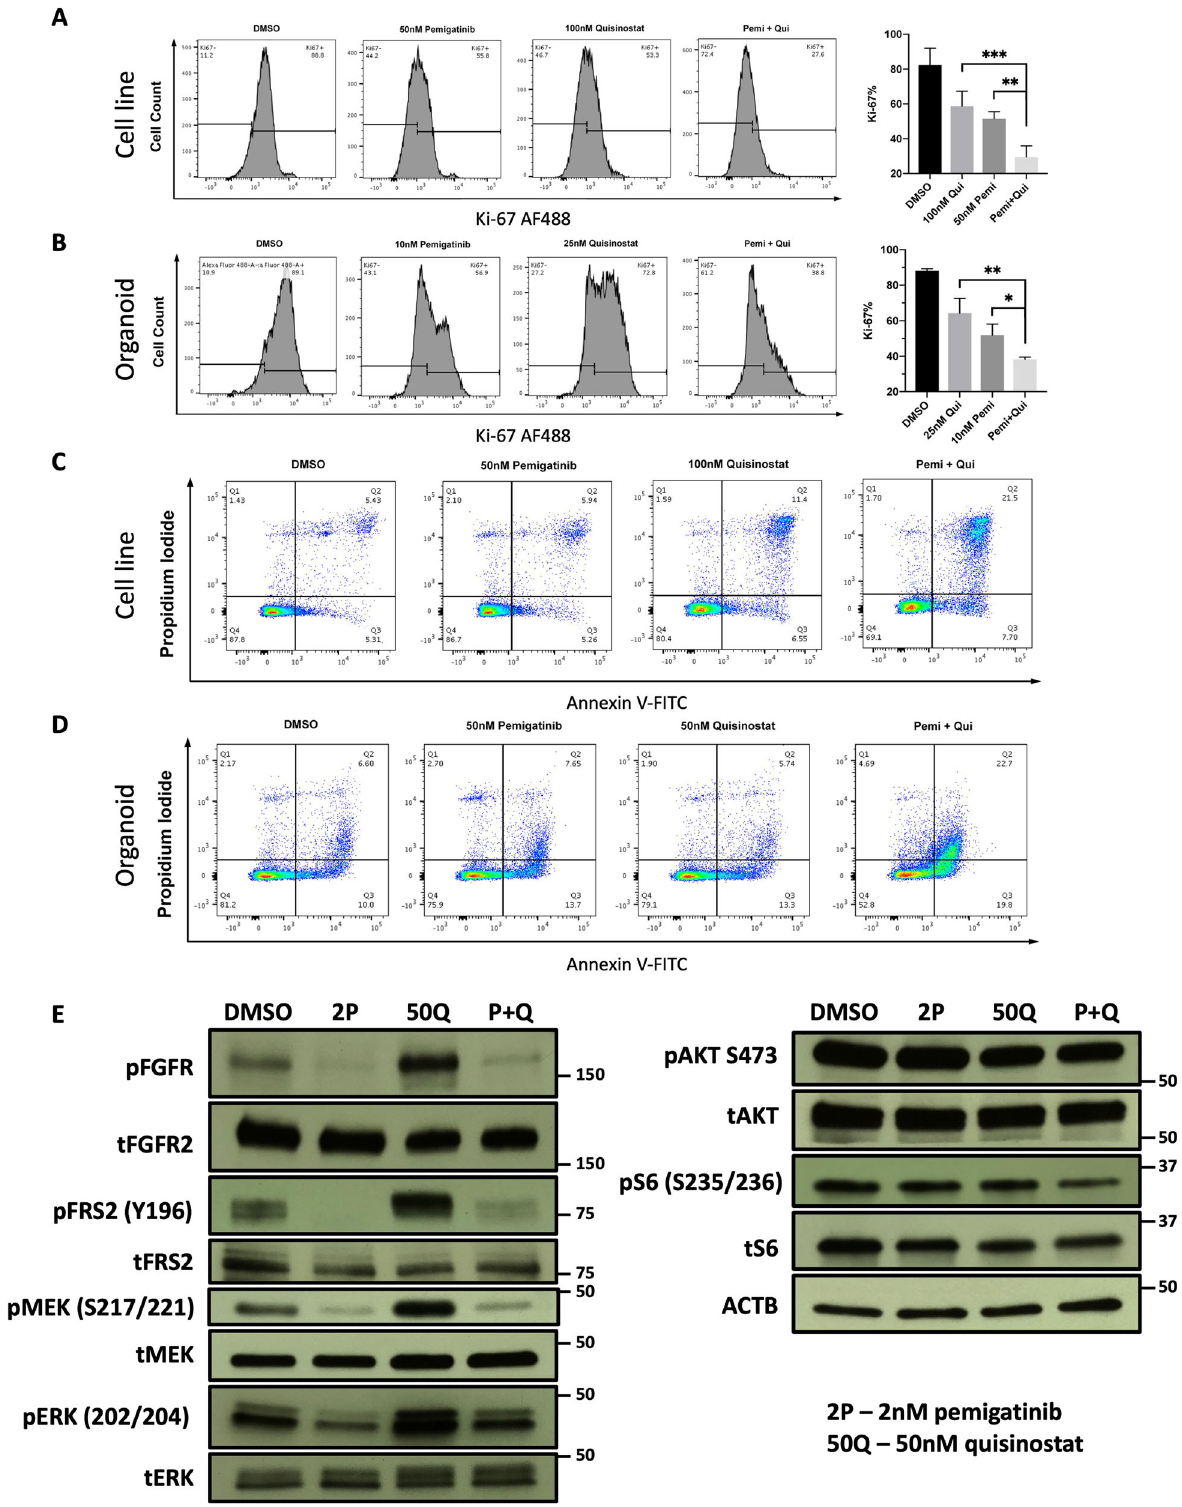
pre-clinical models of FGFR2 fusion-positive ICC, thus there is a desperate need to develop novel patient-derived models of this disease to optimize the likelihood of translatability in any data generated, and to use these models to discover additional therapeutic strategies with the potential for improved